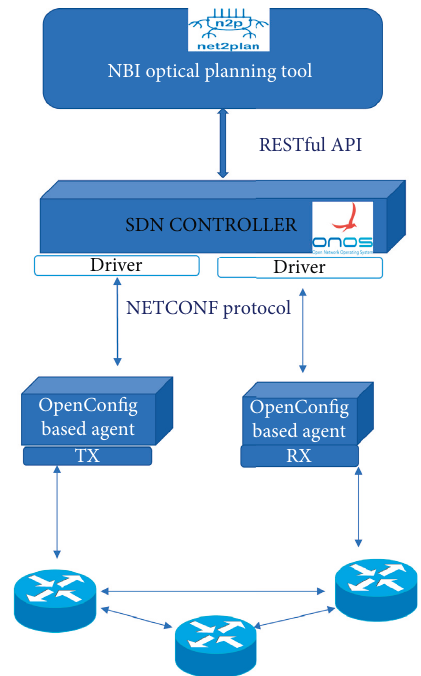
Figure 15: Architecture illustrating the need of SBI